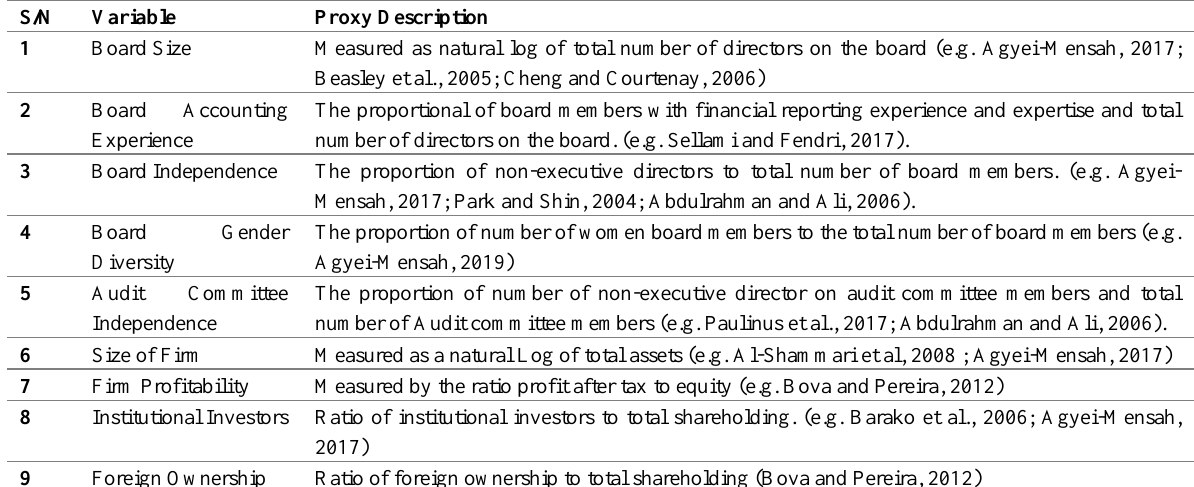
Table 1: Operationalization of the Independent and Control